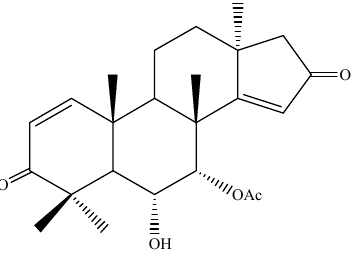
Figure 18. The structures of octanortriterpenoids.